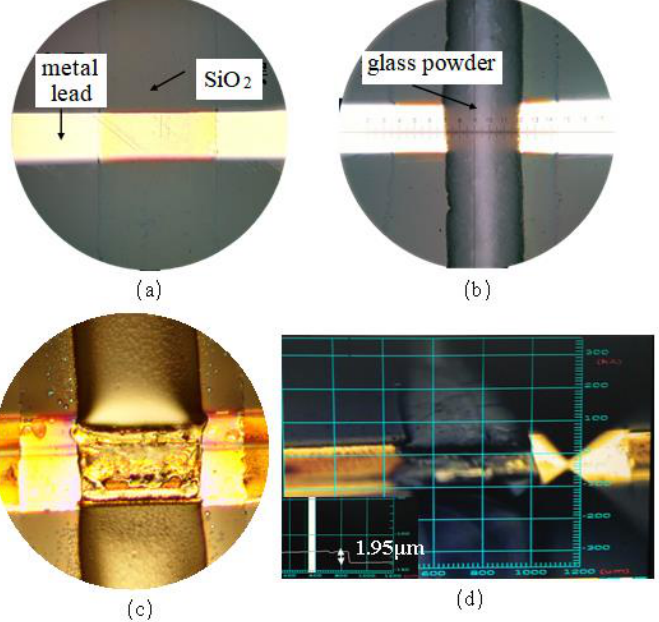
Figure 8. Isolation layer pre-sintering: ( a ) deposition of SiO 2 ; ( b ) printing glass paste; ( c ) high temperature hot-melt glass; ( d ) characterization of glass powder thickness.